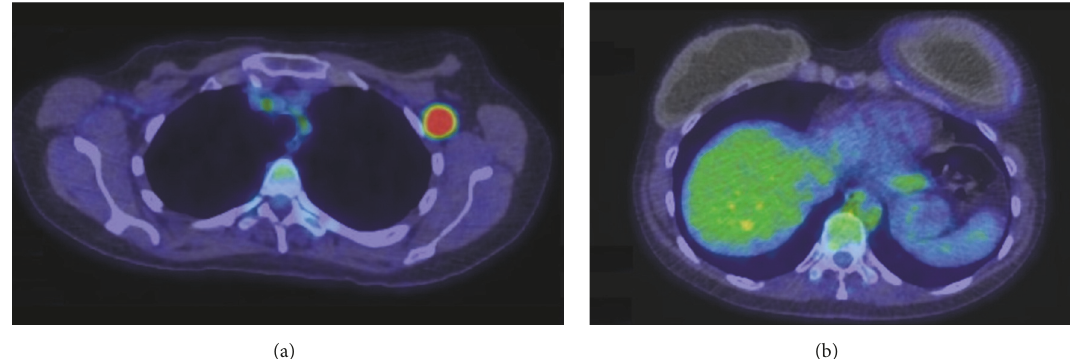
Figure 1: PET-CT scan images. (a) Pathologically enlarged, metabolically active left axillary lymph node. (b) Metabolically active thickening and seroma around left breast implant.